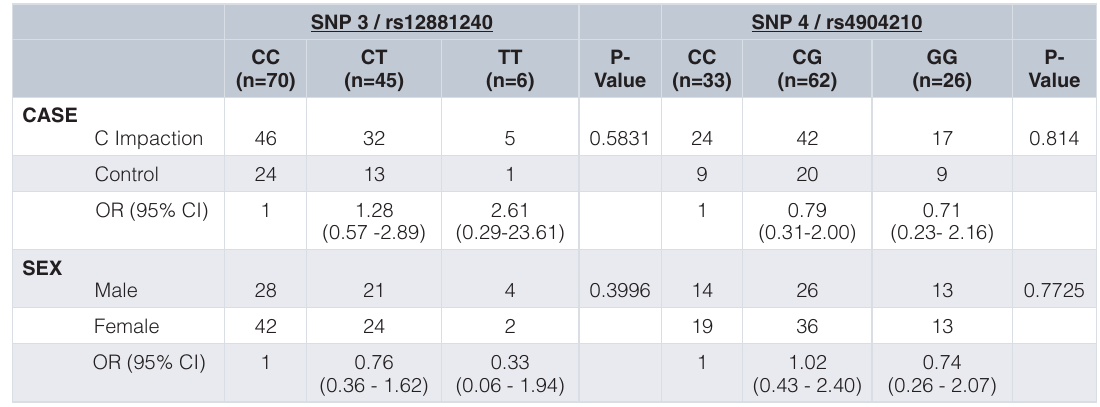
Table 9. Associations between gender and SNP